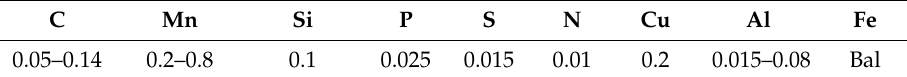
Table 1. Chemical composition of non-alloy structural steel S235JR (EN 10025-2) according to the Thyssenkrupp manufacturer’s data (wt. %), Figure 1. Table 2. Nominal composition of Fe-based experimental powder (wt. %).